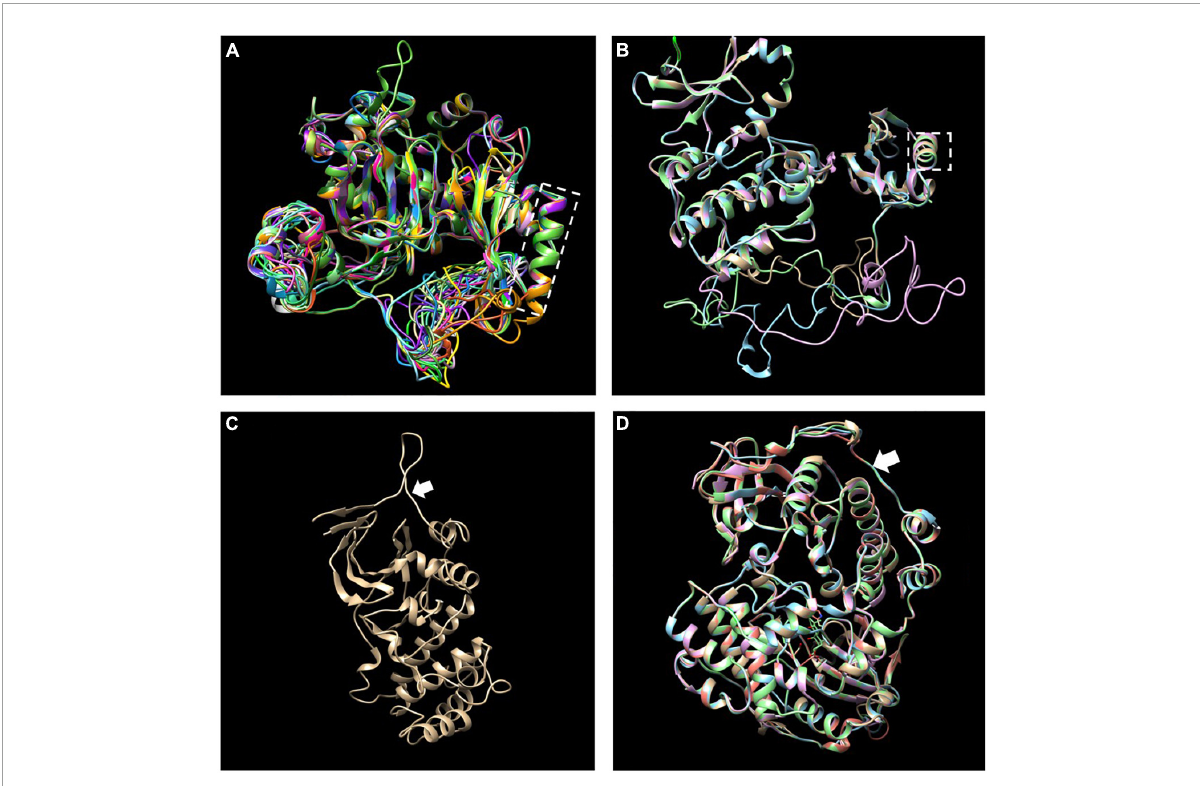
FIGURE2 Merged three-dimensional (3D) structure of 37 LiCIPKs. (A) Merged 3D structure of LiCIPKs belong to class A to E. (B) Merged structure of LiCIPKs belong class F. (C) 3D structure of class G. (D) Merged structure of LiCIPKs class H. The classes A to H are depicted on Supplementary Figure 2 . The dashed box indicates the α -helix of PPI domain; arrow indicates the junction between the N and